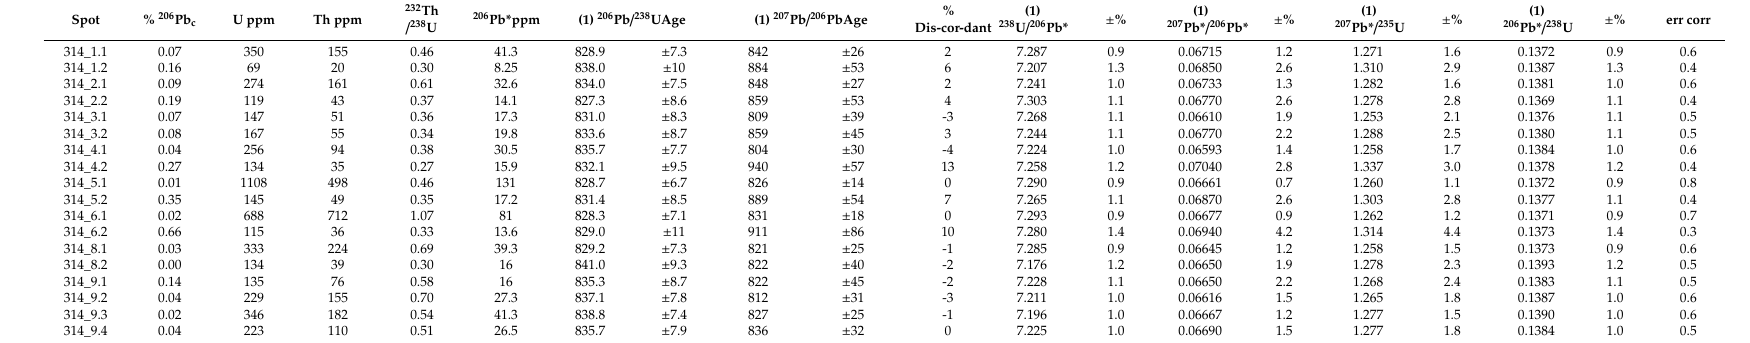
Table 1. Sensitive High-Resolution Ion Microprobe (SHRIMP) zircon U–Pb dating results for trachyandesite